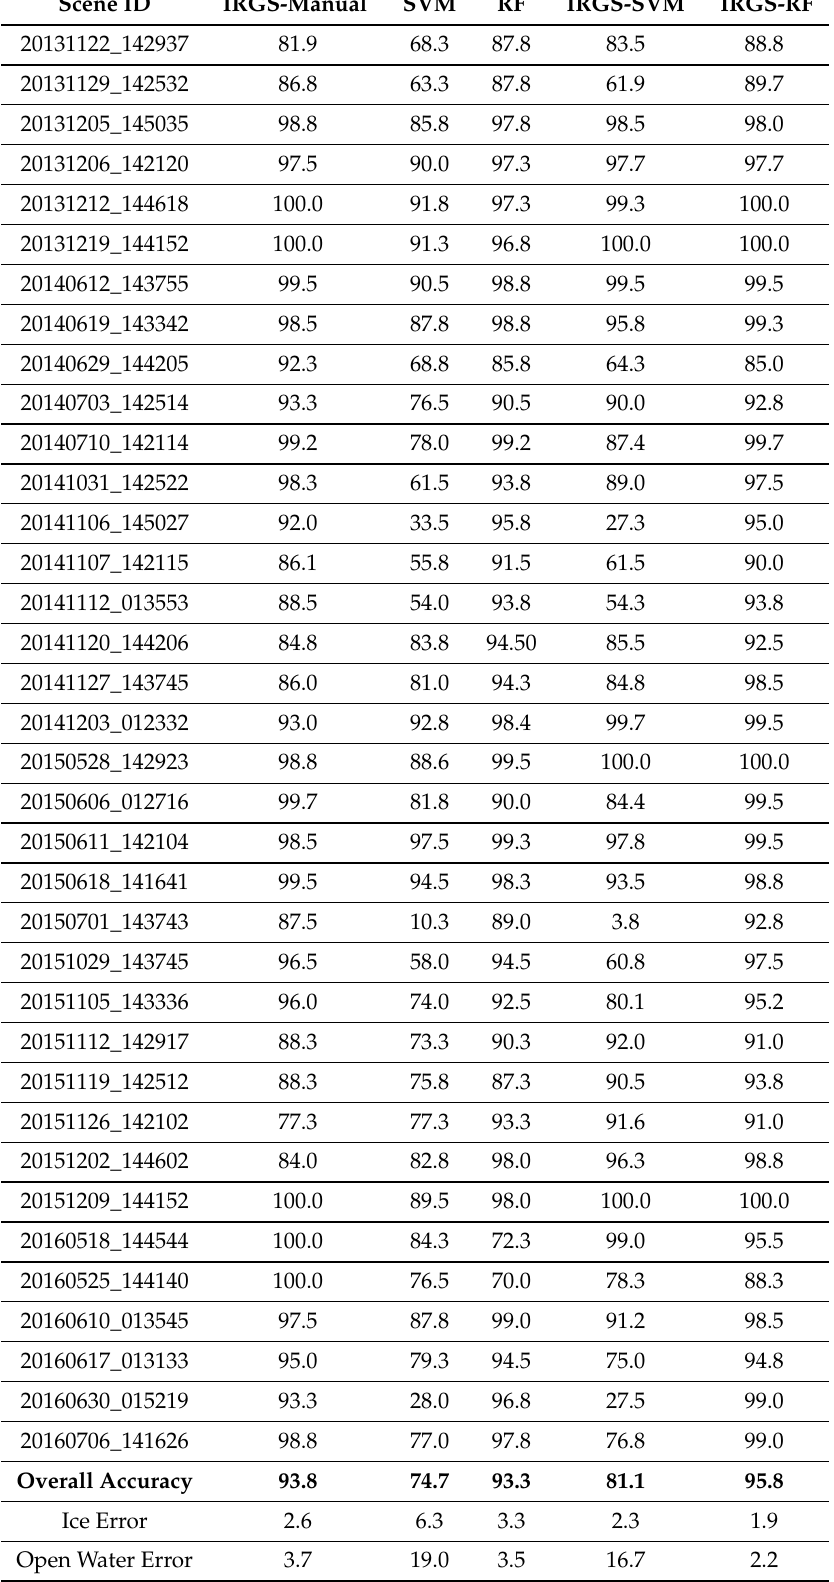
Table 4. Classification accuracy results of each tested method for all 36 scenes (shown in percent). Accuracy and error totals may not add to 100% due to